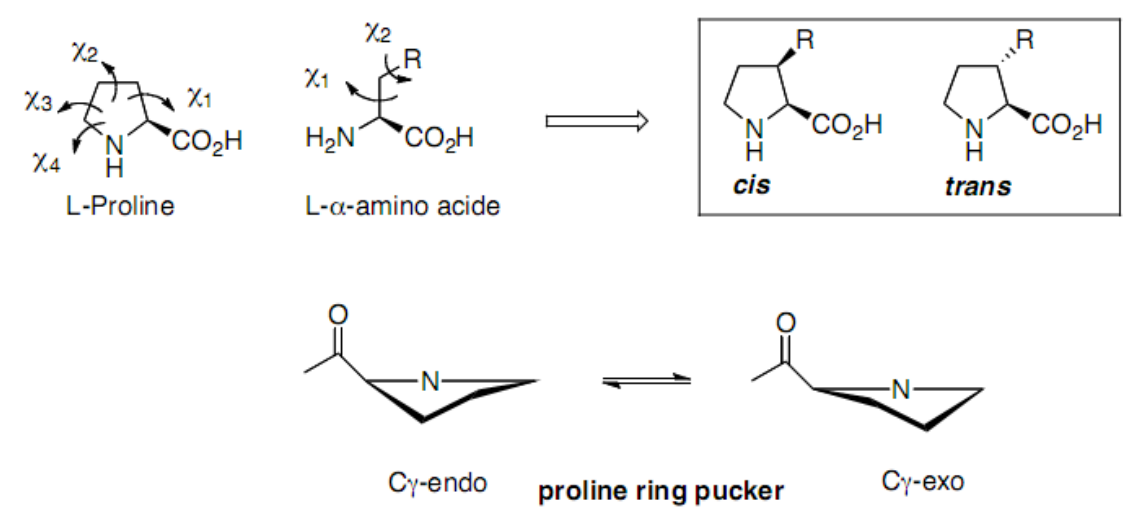
Figure 3. Schematic representation of trans and cis -3-prolinoamino